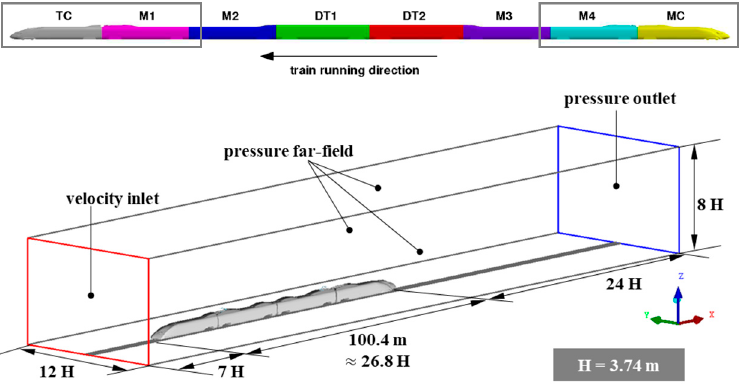
Figure 2. Computational domain for open field case (1H: height of train). Table 2. Details on boundary setting for the open field case.